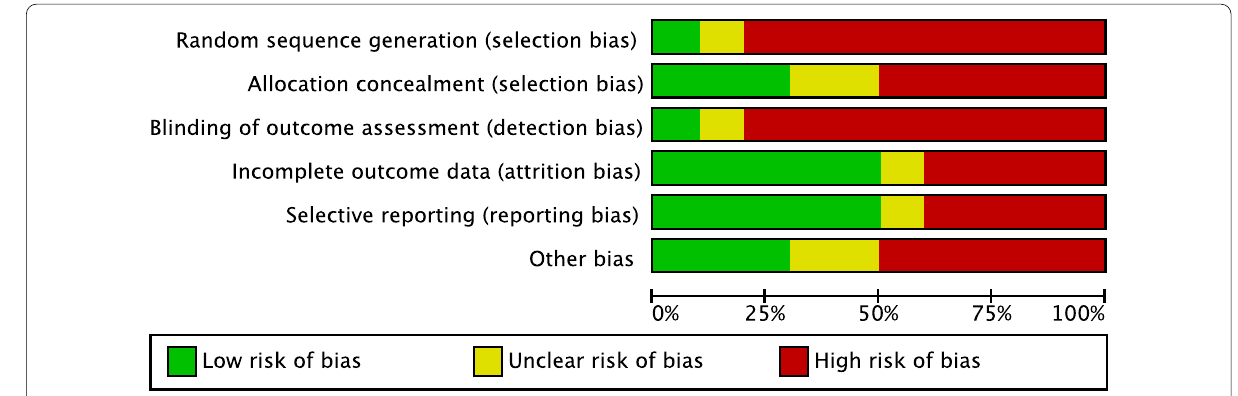
Fig. 2 Methodological quality